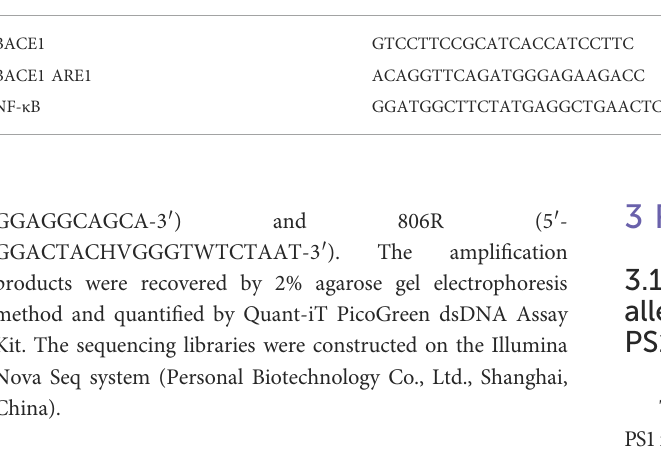
algorithm. The random forest analysis and nested hierarchical